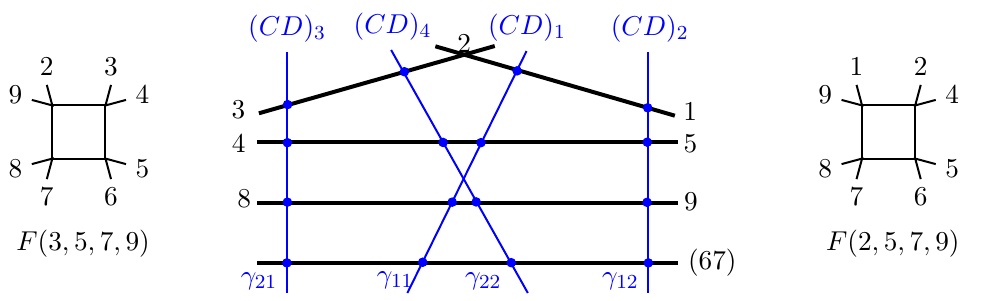
Figure 3 . Two different one-loop configurations at n = 9 and their solutions; intersections on the line (67) are checked to be